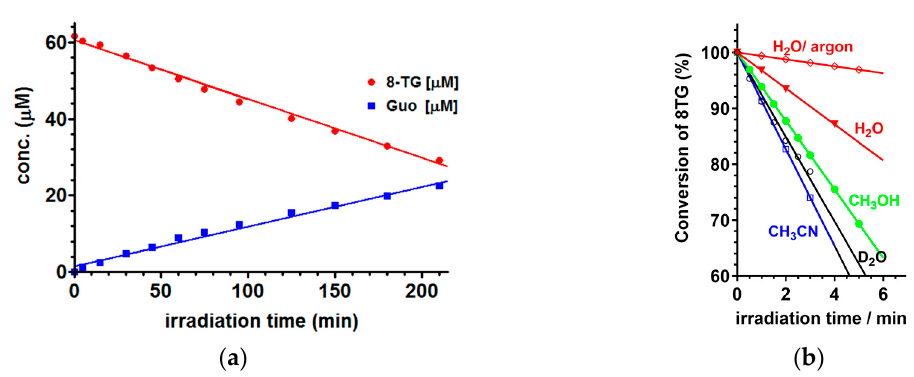
Figure 3. ( a ) The concentration of 8-TG (red) and Guo (blue) as a function of the irradiation time in air-equilibrated aqueous solution. ( b ) Rates of substrate disappearance upon radiation at λ > 300 nm of 8-TG in air-equilibrated solutions with different